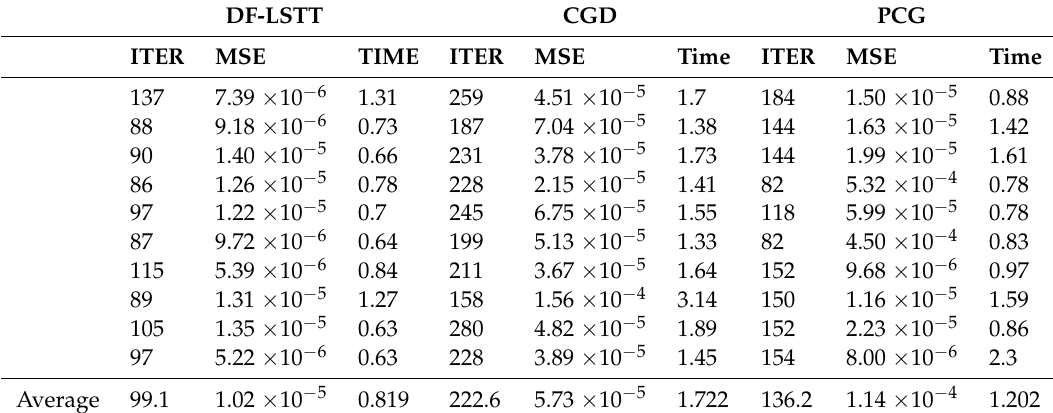
Table 1. Results for sparse signal recovery.